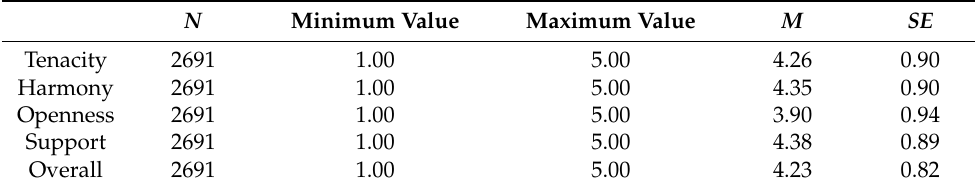
Table 3. Family resilience situation.